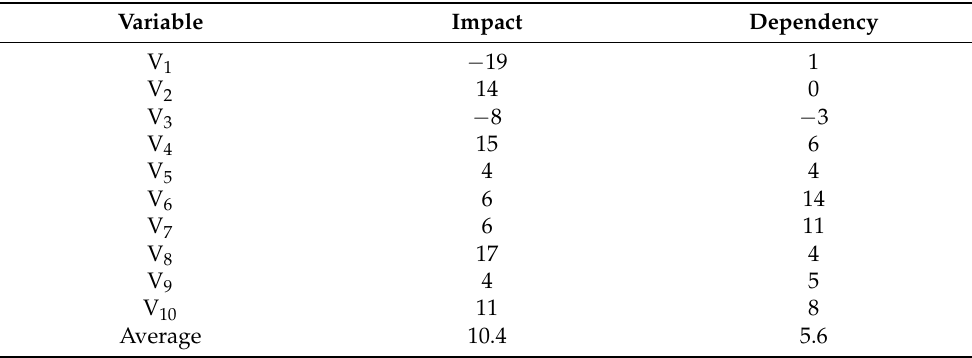
Table 9. Impact and dependency values for each variable.